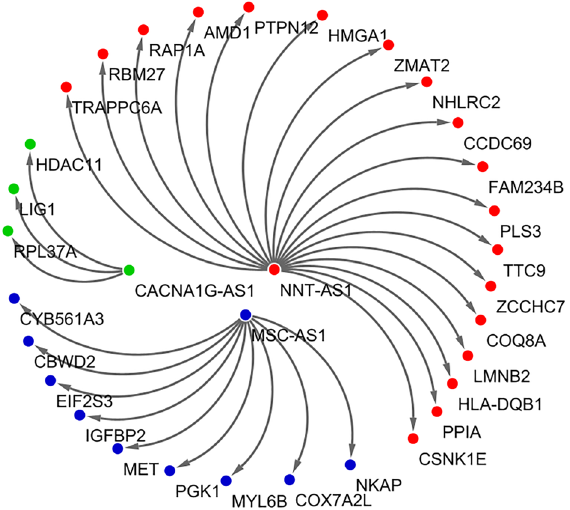
Figure 7. lncRNA-mRNA interaction network showing protein-coding genes targeted by the CACNA1G-AS1, NNT-AS1, and MSC-AS1.